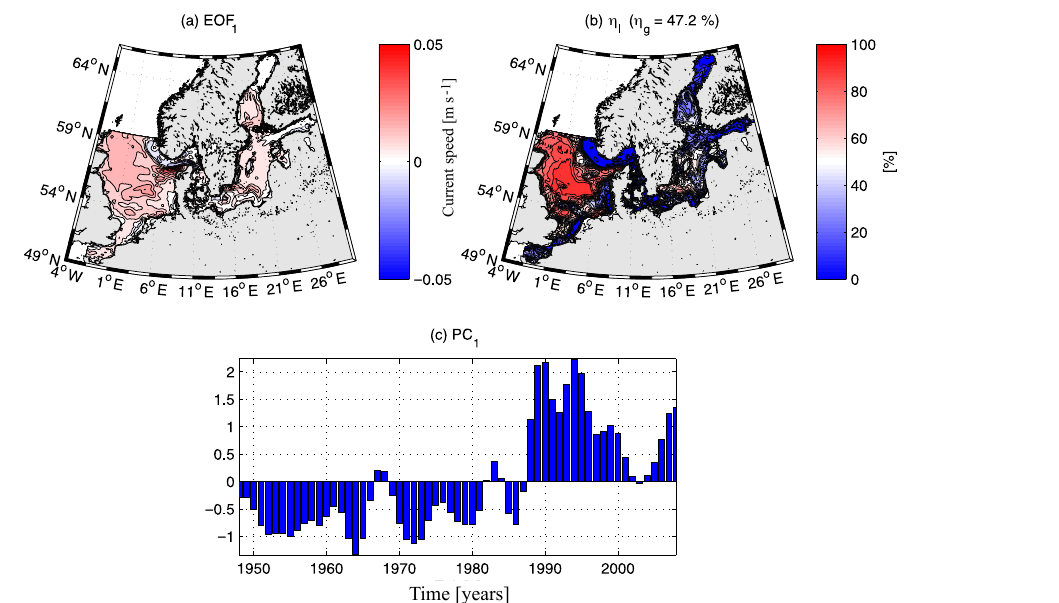
Figure 8. EOF analysis of the anomalies in current speed for the winter period January–March: (a) current speed pattern for the first EOF; (b) local explained variance; (c) first principal